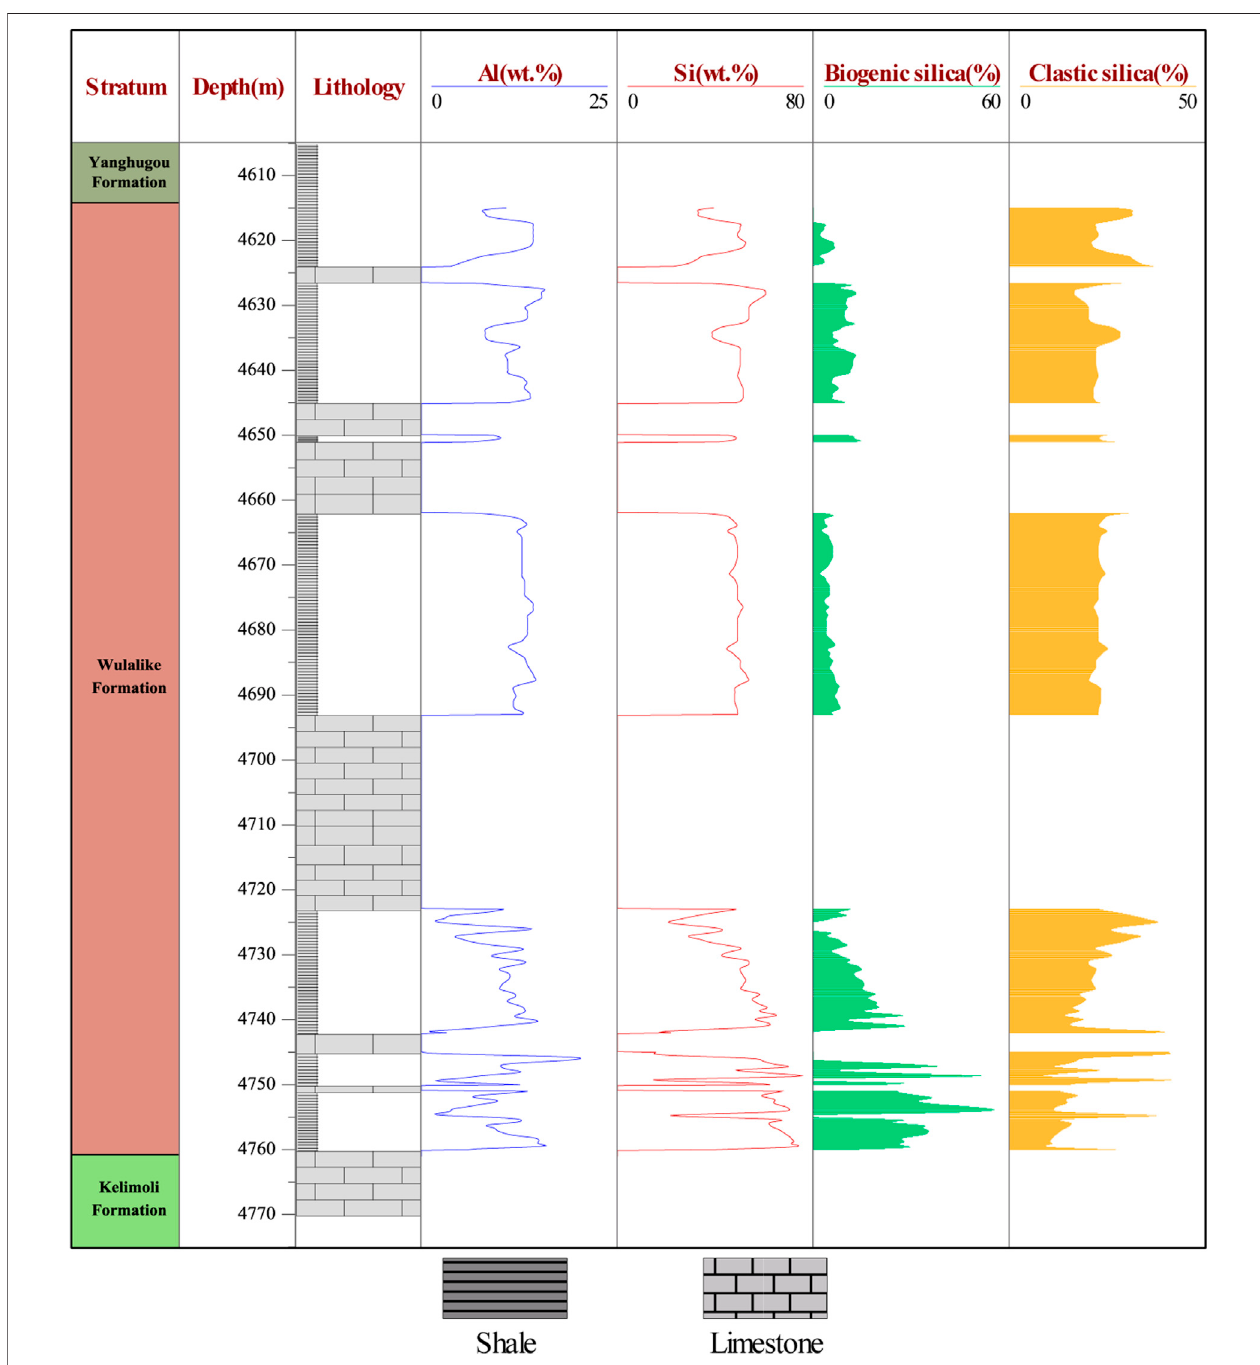
FIGURE 10 | Siliceous mineral origin from the well A in the Wulalike formation (location given in Figure 1B ).